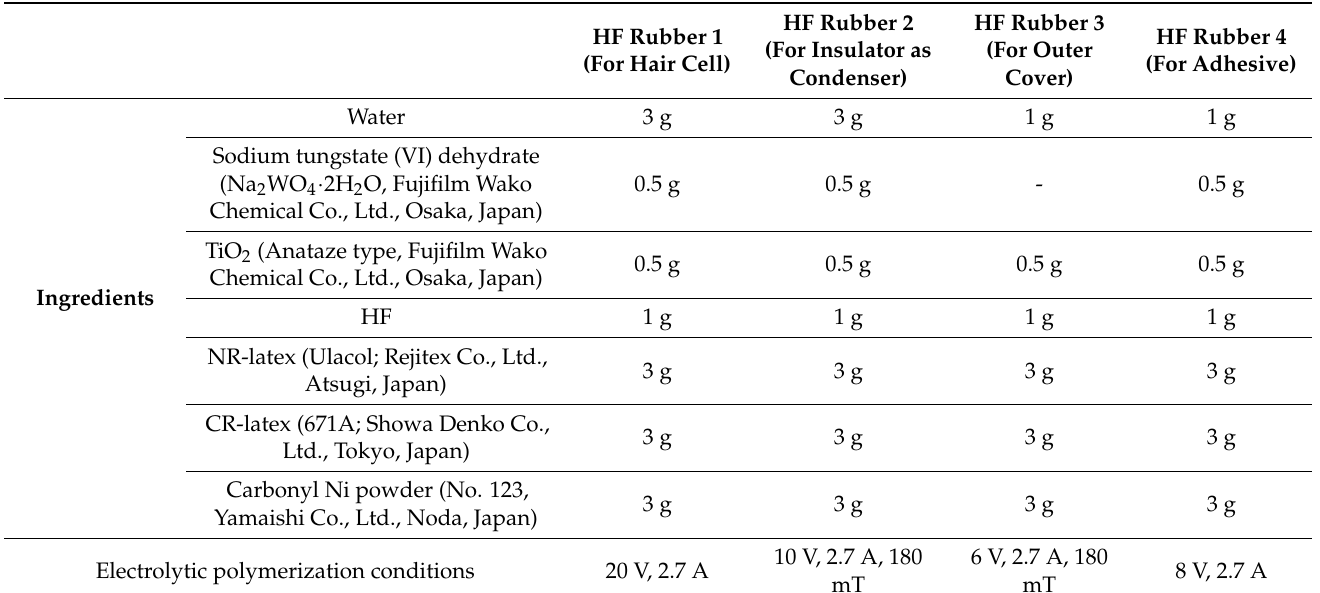
Table 1. Ingredients of HF rubber for the fabrication of the receptor.